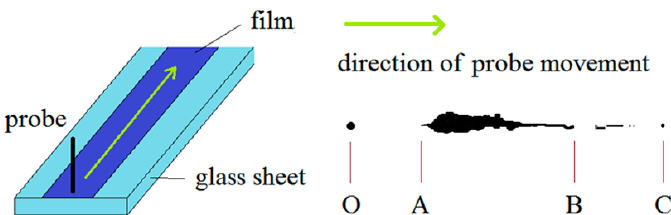
Figure 1. The drying time test method and trace of a coating during the drying process. O → A: The film possessed good fluidity. The trace disappeared after the probe. A → B: The surface of the film had dried, but the base had not. The film surface adhered to the probe and left behind thick traces. B → C: The film had dried further. The probe left only fine marks after crossing the film. C: The film had completely dried. The probe did not leave any trace.